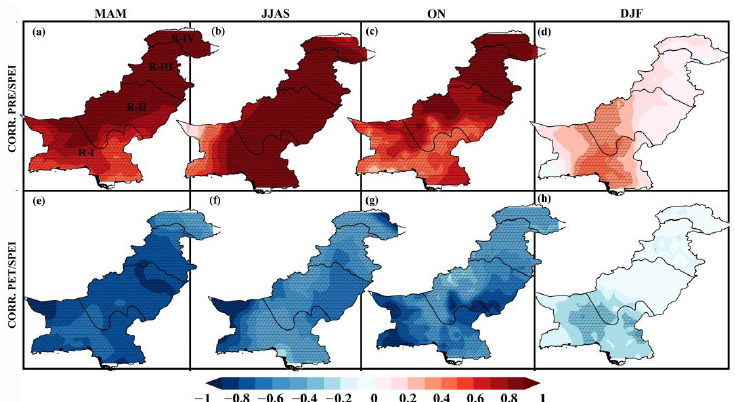
Figure 10. Spatial distribution of correlation between rainfall and SPEI for ( a ) MAM (March to May), ( b ) JJAS (June to September), ( c ) ON (October to November), and ( d ) DJF (December to February) seasons over the China Pakistan Economic Corridor for 1980 – 2018. The lower panel (e-h) is the same as the top panels but for PET. The hatched area shows a statistically significant trend at a 90% confidence level. R-I, R-II, R-III, and R-IV represent the hyper-arid, arid, humid, and glacial regions, respectively.